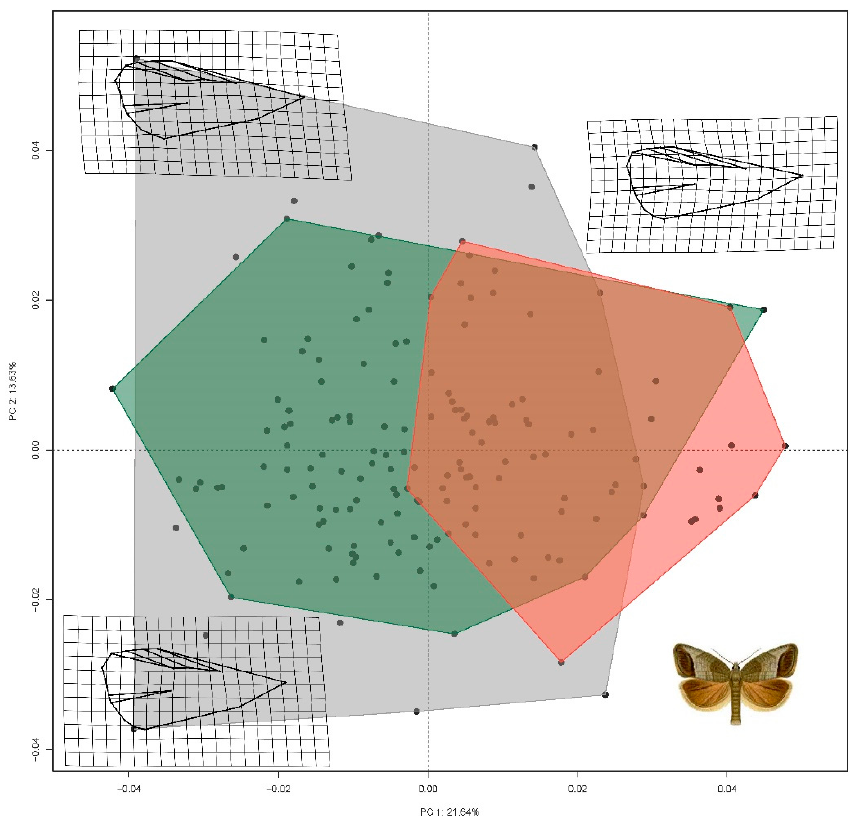
Figure 7. Principal component analysis of the average forewing shape among different popula- tions from integrated orchard, organic orchard, and laboratory populations of Cydia pomonella : red, integrated orchard; green, organic orchard; gray, laboratory